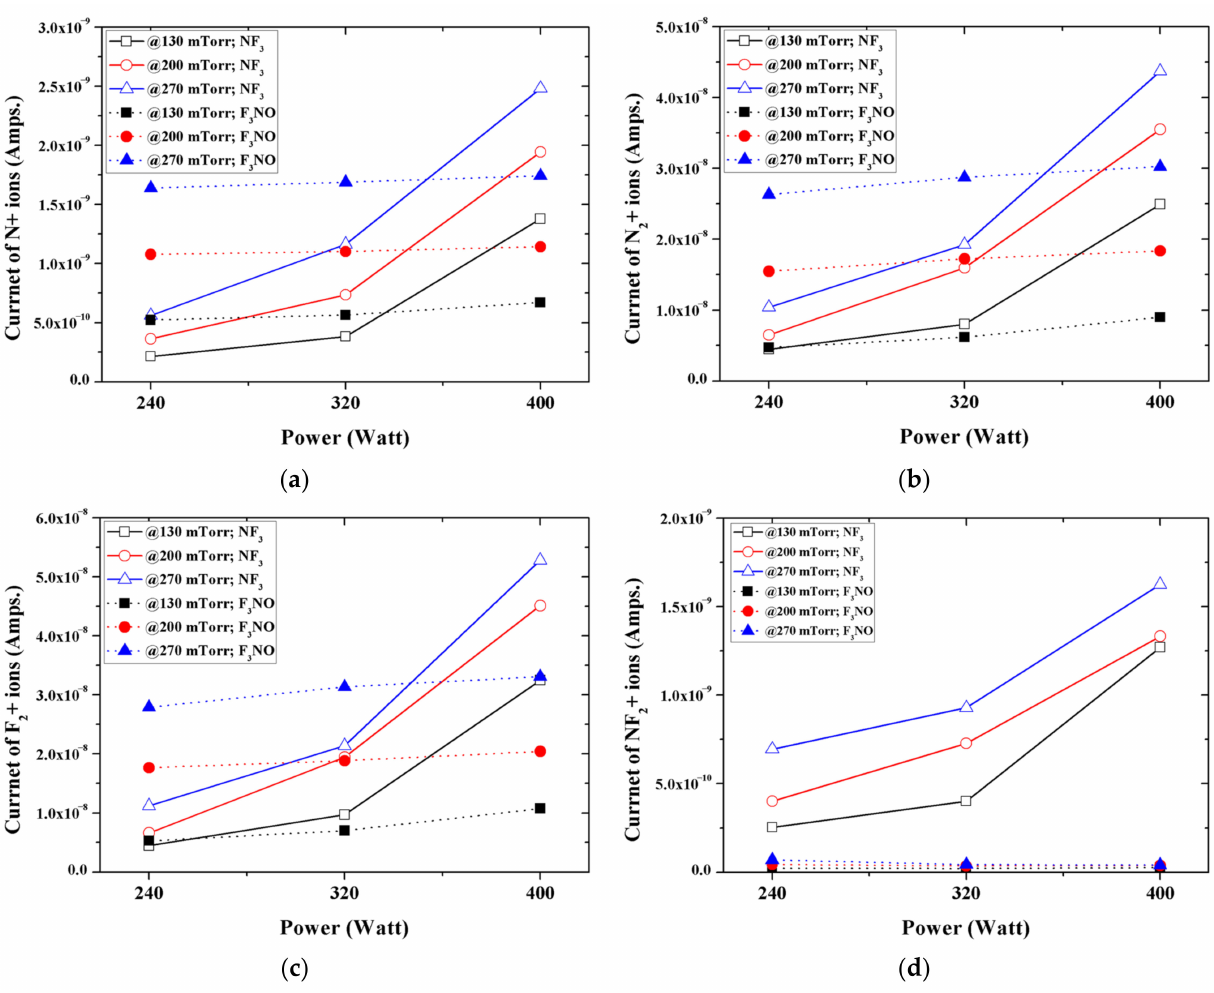
Figure 5. Intensity of: ( a ) N+ ions; ( b ) N 2 + ions; ( c ) F 2 + ions; ( d ) NF 2 + ions during plasma silicon oxide etching as functions of the input power for various working